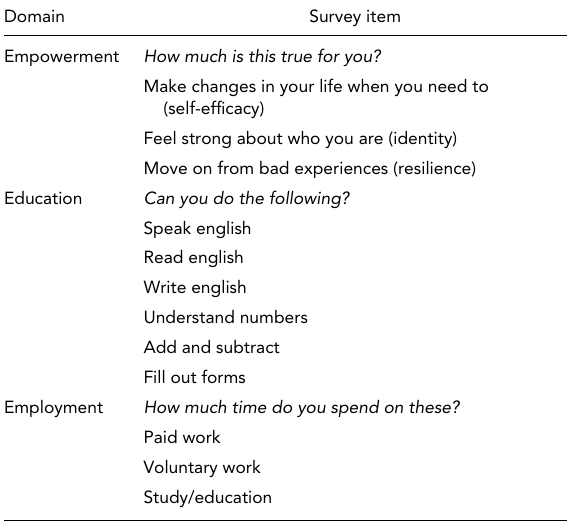
Domains and Survey Items Taken from the Interplay Survey